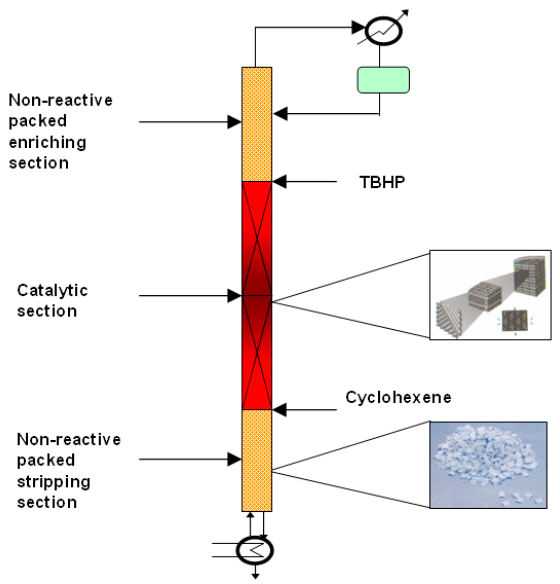
Figure 2. Schematic of an RDC